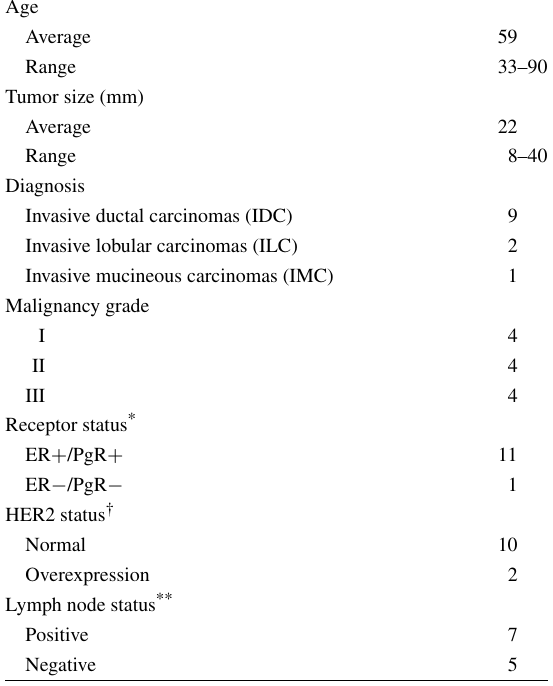
Clinical characteristics of the 12 breast cancer